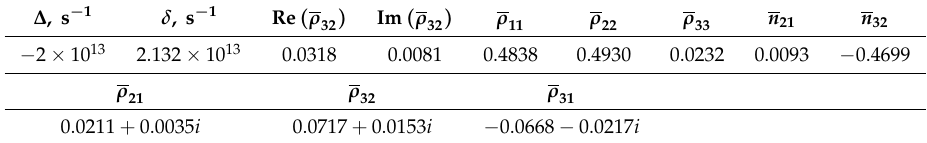
Figure 10. ( a ) The frequency dependencies of real (solid red line) and imaginary (dashed blue line) parts of ρ for fixed detuning ∆ = ∆ m . ( b ) The time dependencies of the real parts of ρ 32 (thin green 32 and red lines) and ρ 12 (thick blue and red lines) calculated by using Equation (24) (dashed lines) and by using direct numerical simulation (solid lines) of the full system of differential Equation (20) for density matrix elements upon Ladder-type interaction of two SPP modes and core–shell NW. Table 5. The stationary solutions of the system in Equation (20) and corresponding frequency detunings.